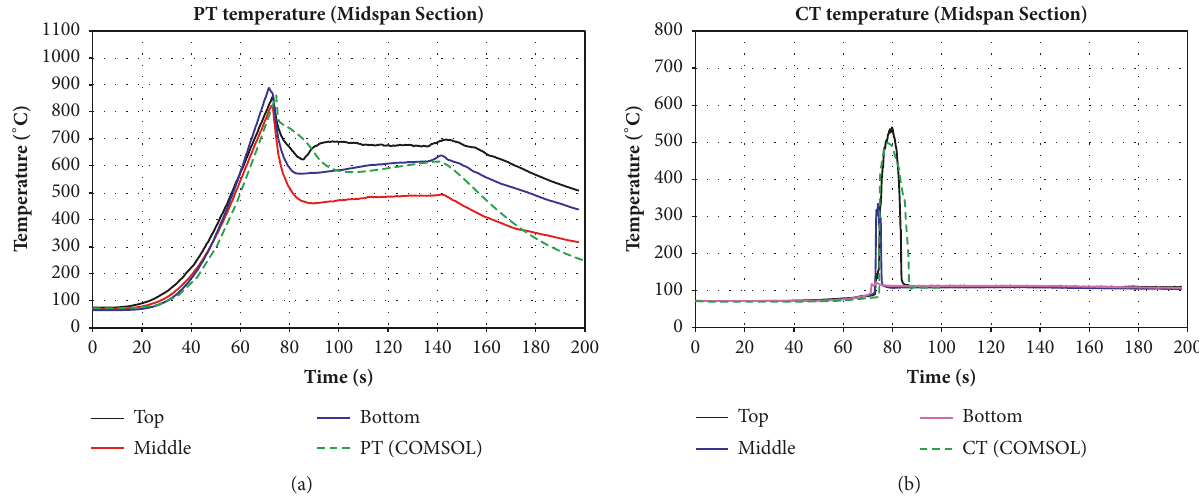
Figure 7: Measured and computed temperature at (a) the inner surface of PT and (b) the outer surface of CT, Amp = 20.